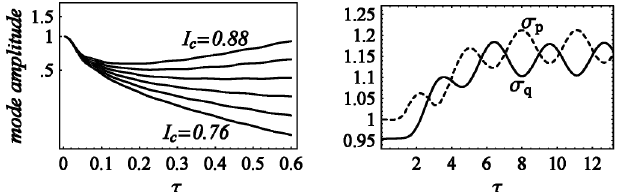
FIG. 6. Bunched beam. Left: Logarithm of the amplitude of Fourier mode n (cid:2) 702 versus time for six values of the current (cid:2) 0 : 76 and I (cid:2) 0 : 88 in steps of (between I parameter I c c c (solid line) and 0.024). Right: normalized rms bunch length (cid:8) q (cid:2) 0 : 98 energy spread (cid:8) (dashed line) versus time for I p c